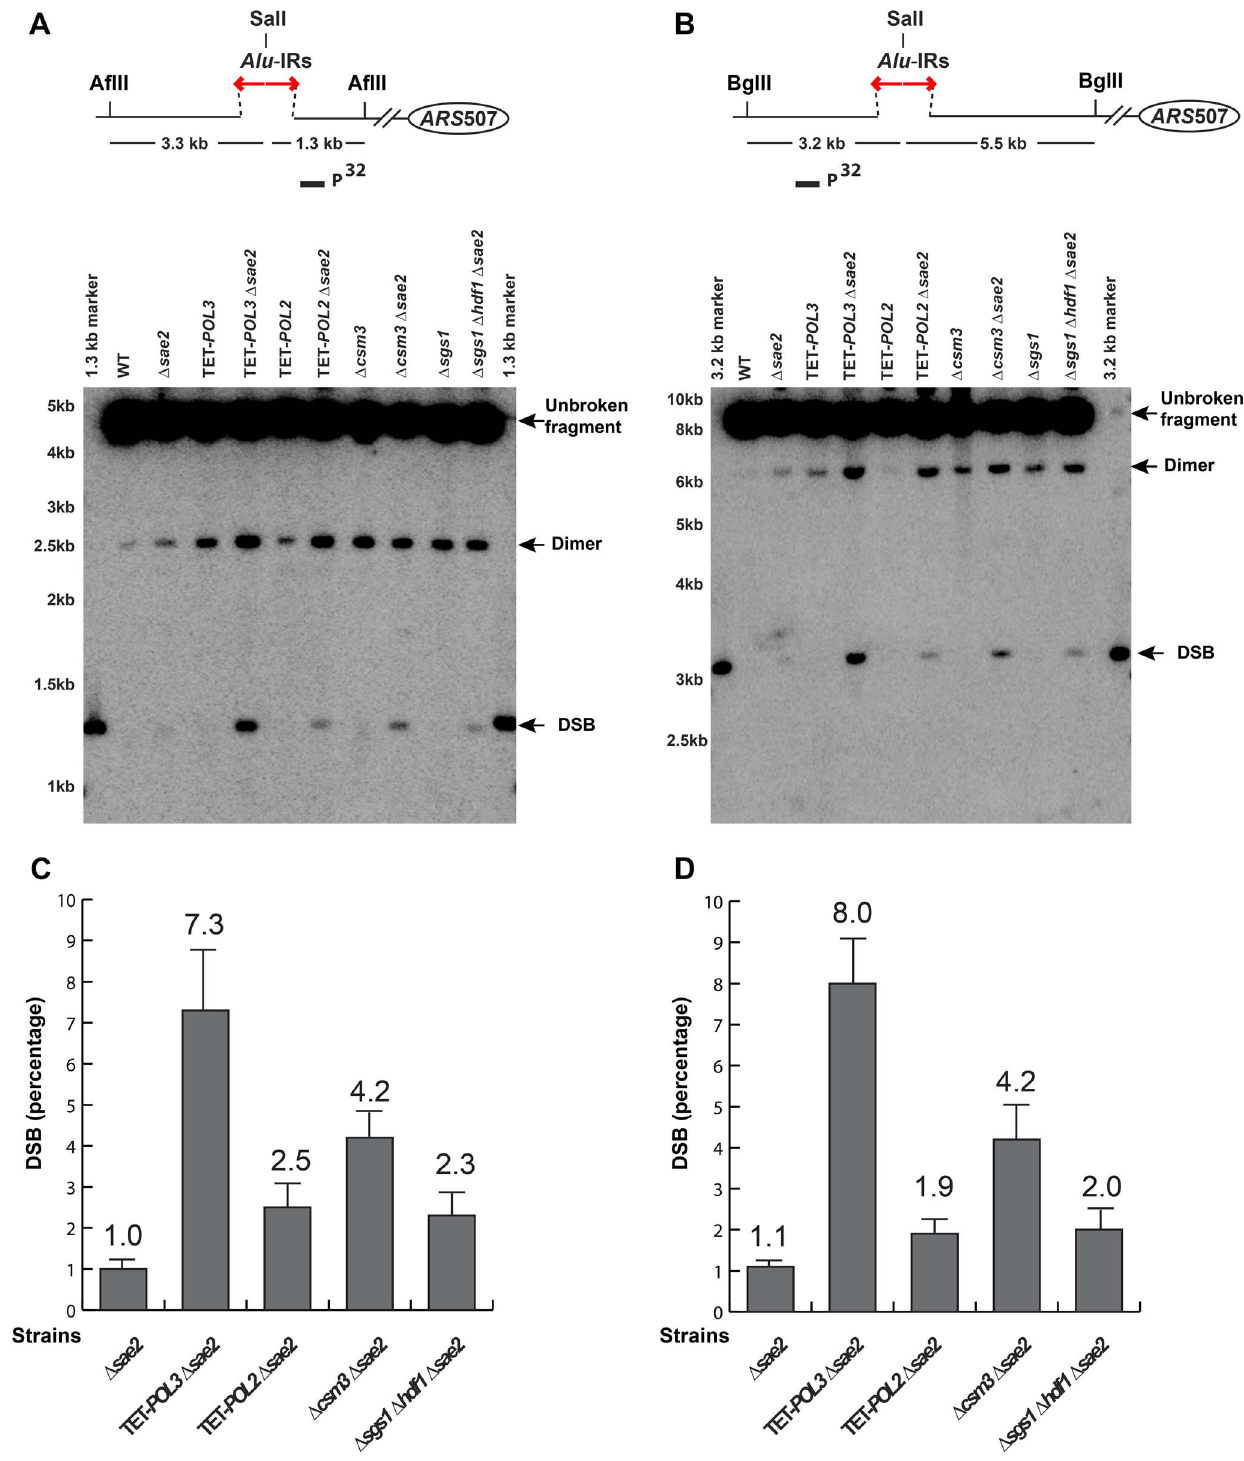
Figure 2. Physical detection of breakage intermediates in the wild-type and mutant strains carrying 100% Alu -IRs. Yeast genomic DNA embedded in agarose plugs was digested with either AflII ( A ) or BglII ( B ). The relative positions of the repeats, the restriction sites and the replication origin ARS 507 are illustrated. Digested DNA was separated by gel electrophoresis. Southern hybridization using LYS2 -specific probes (solid rectangles) was carried out to detect the chromosomal fragments centromere-proximal ( A ) or distal ( B ) to the breaks induced by Alu -IRs. For the centromere-proximal intermediates ( A ), the size of unbroken fragment, dimer and DSB fragment are 4.6 kb, 2.6 kb and 1.3 kb, respectively. For the centromere-distal intermediates ( B ), the size of unbroken fragment, dimer and DSB fragment are 8.7 kb, 6.4 kb and 3.2 kb, respectively. Bands corresponding to the unbroken fragment, dimer and DSB fragment are indicated by arrows. The 1.3 kb marker and 3.2 kb marker were generated by digesting genomic DNA from the wild-type Alu -IRs strain with SalI + AflII ( A ) or SalI + BglII ( B ), where SalI cuts inside the 12 bp spacer of the Alu -IRs. The strains used for analysis are: wild-type, D sae2 , TET- POL3 , TET- POL3 D sae2 , TET- POL2 , TET- POL2 D sae2 , D csm3 , D csm3 D sae2 , D sgs1 , D sgs1 D hdf1 D sae2 . ( C )